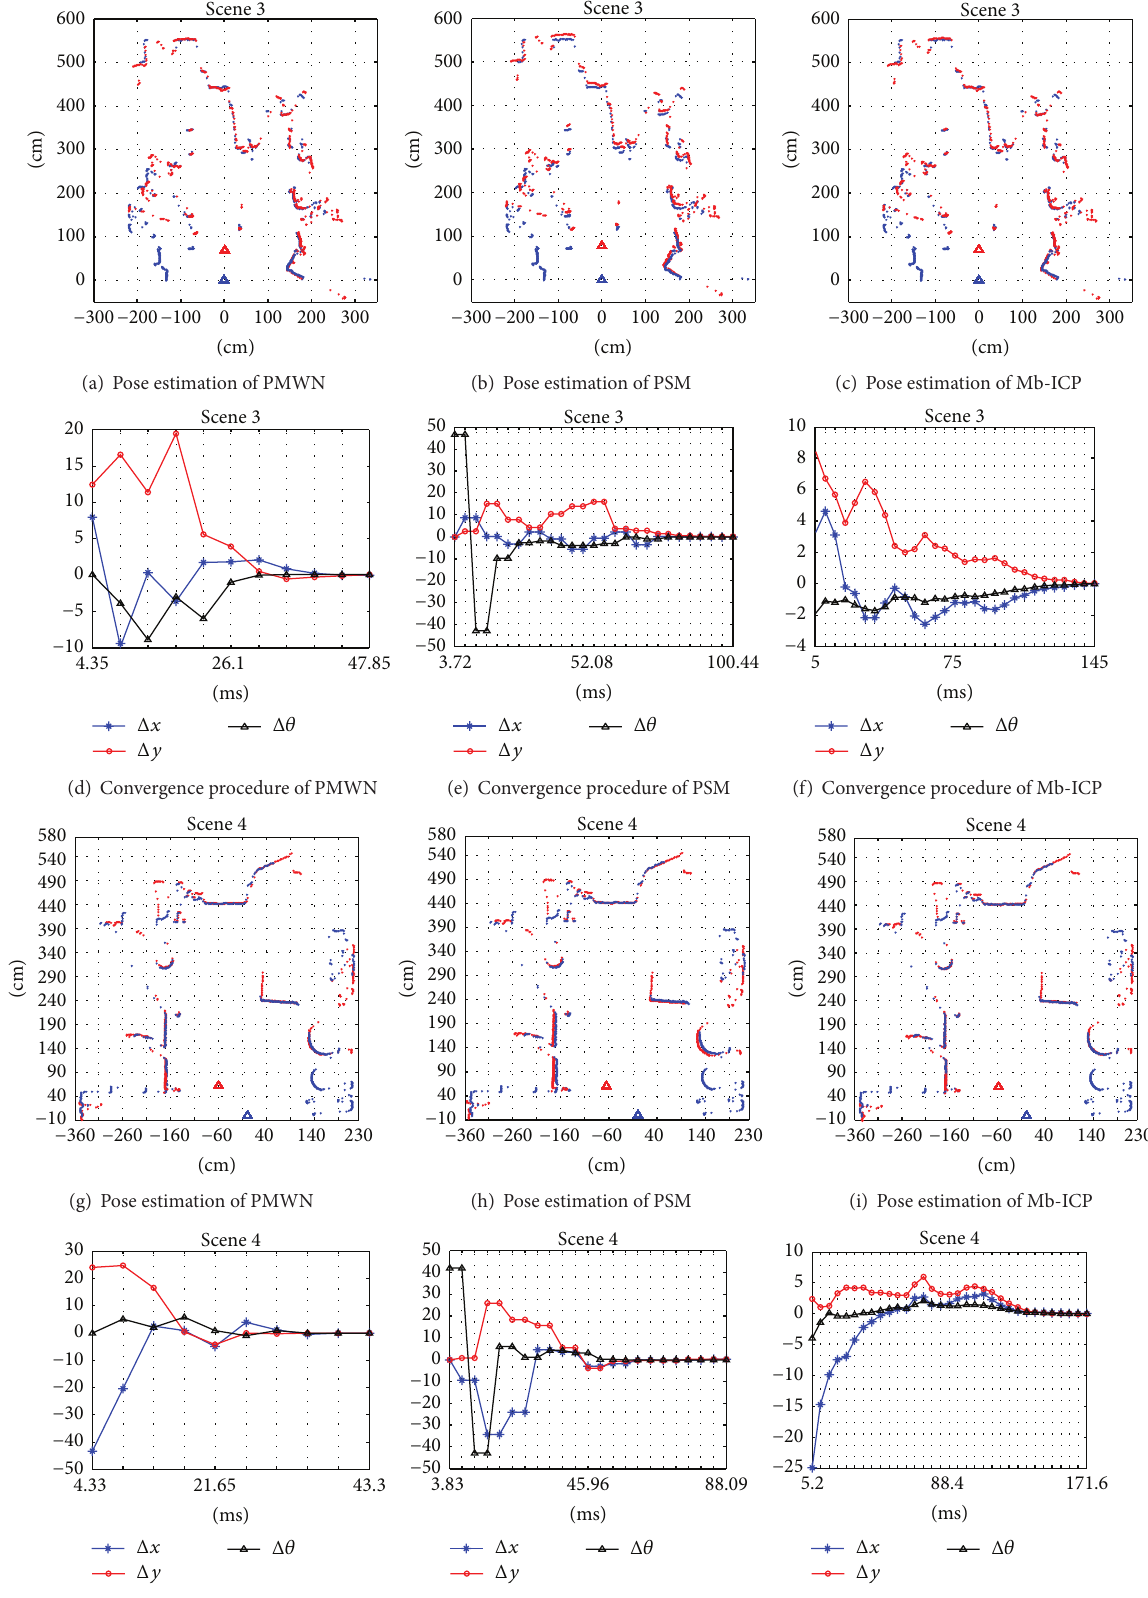
Figure 11: Scenes in Environment